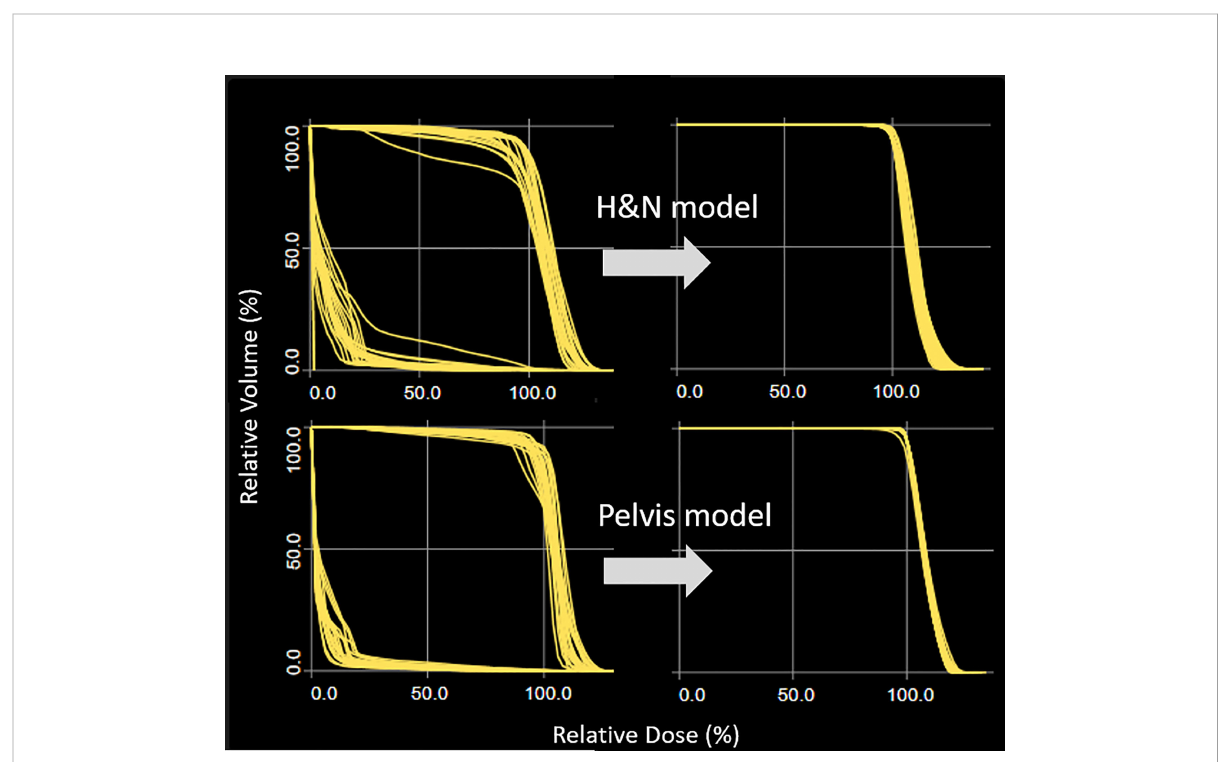
FIGURE 1 Target DVH distribution for H&N and pelvis plans. Optimization when chest plan is used as the base dose resulted in a wide target DVH range (left column). The scattered DVH distribution was successfully removed once the model plans were re-optimized without the base